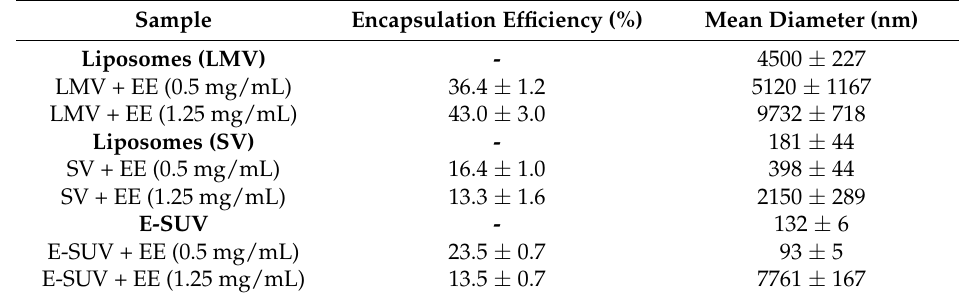
Table 5. Percentage of elderberry extract (EE) encapsulation in soy phosphatidylcholine liposomes (PC = 20 mg/mL) for different methods of liposome formation and mean diameters of